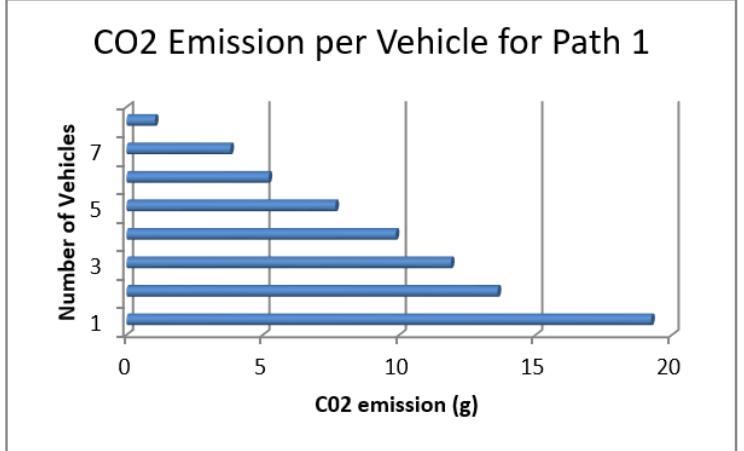
Figure 8. CO2 emission for each vehicle for t2=30 seconds